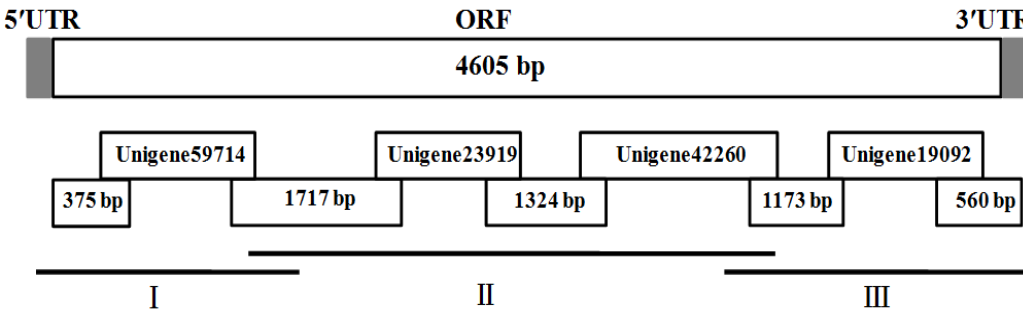
Figure 6. Schematic diagram of the strategy to amplify cDNA of the chitin synthase 1 gene, PcCHS1 , from the citrus red mite, Panonychus citri (Acari: Tetranychidae).The upper bar represents of the cDNA sequence in P. citri . Four PCR fragments were obtained from the P. citri’ s transcriptome data. Fragment II was amplified using specific primers. Fragments I and III were obtained by 5'- and 3'-RACE,